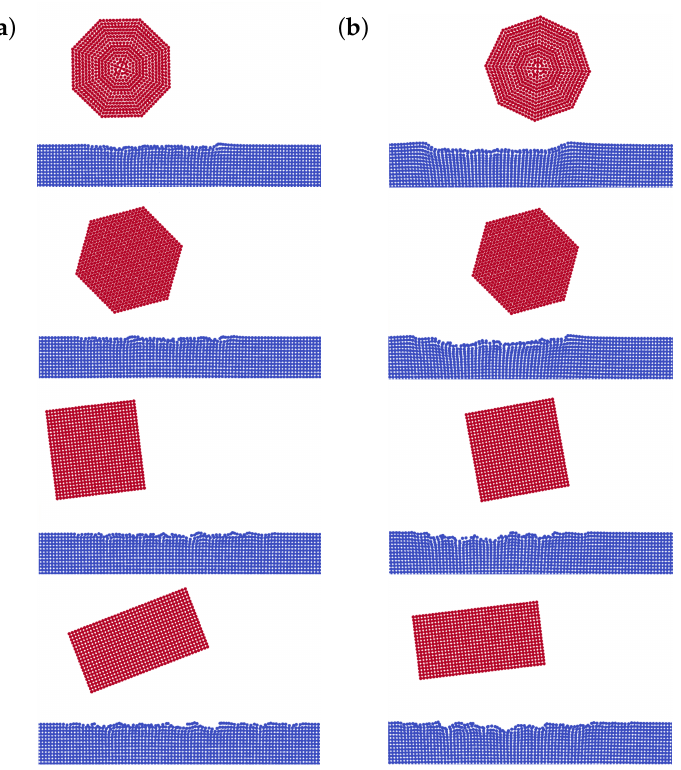
Figure 13. Eroded surface after 50 impacts for impact angle of ( a ) 30° and ( b )